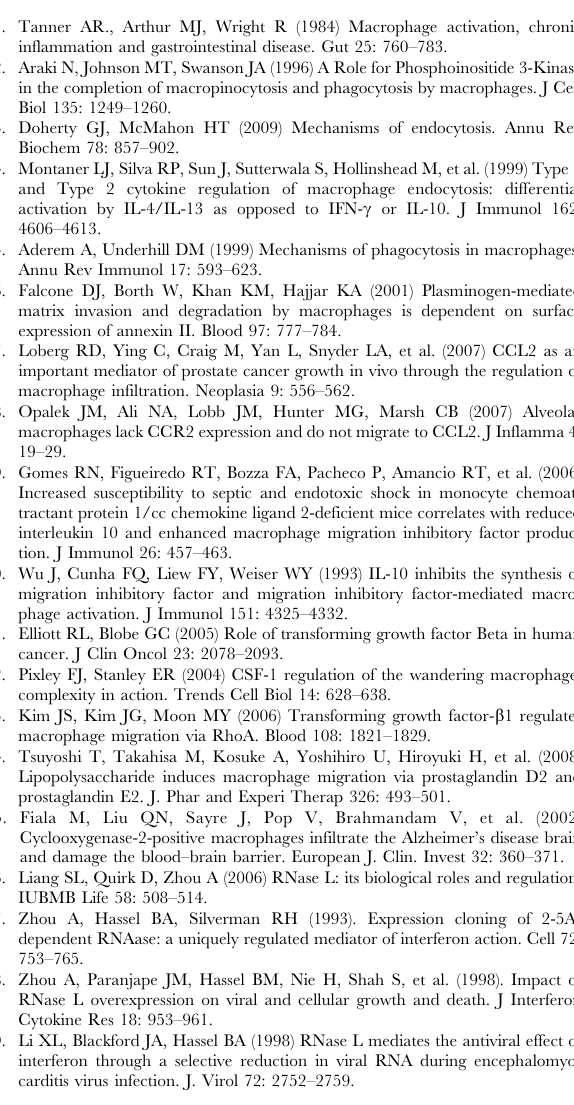
Figure S2 RNase L regulates the expression of cytokines and chemokines in macrophages. RNase L knocking down (Clone 106) and wild type Raw264.7 cells were treated with 1 m g/ ml of LPS for 14 h. The secretory level of certain cytokines and chemokines in the media was measured by using an ELISA kit for each of the analyzers. Experiments were performed two times in triplicates. Data are presented as mean 6 SD. *p , 0.001, **p ,